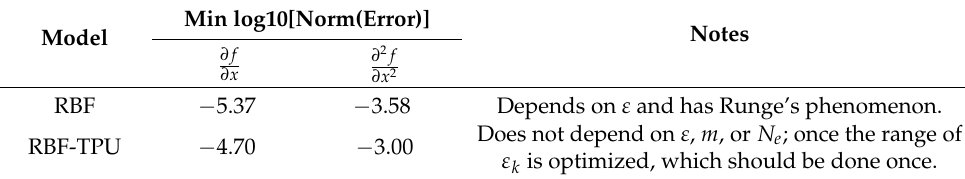
Table 1. Comparison of the minimum error for approximating derivatives (Equations (17) and (18)) between Gaussian radial basis function (RBF) and partition of unity for Taylor series RBF (RBF-TPU). The results of RBF-TPU are obtained from Figure